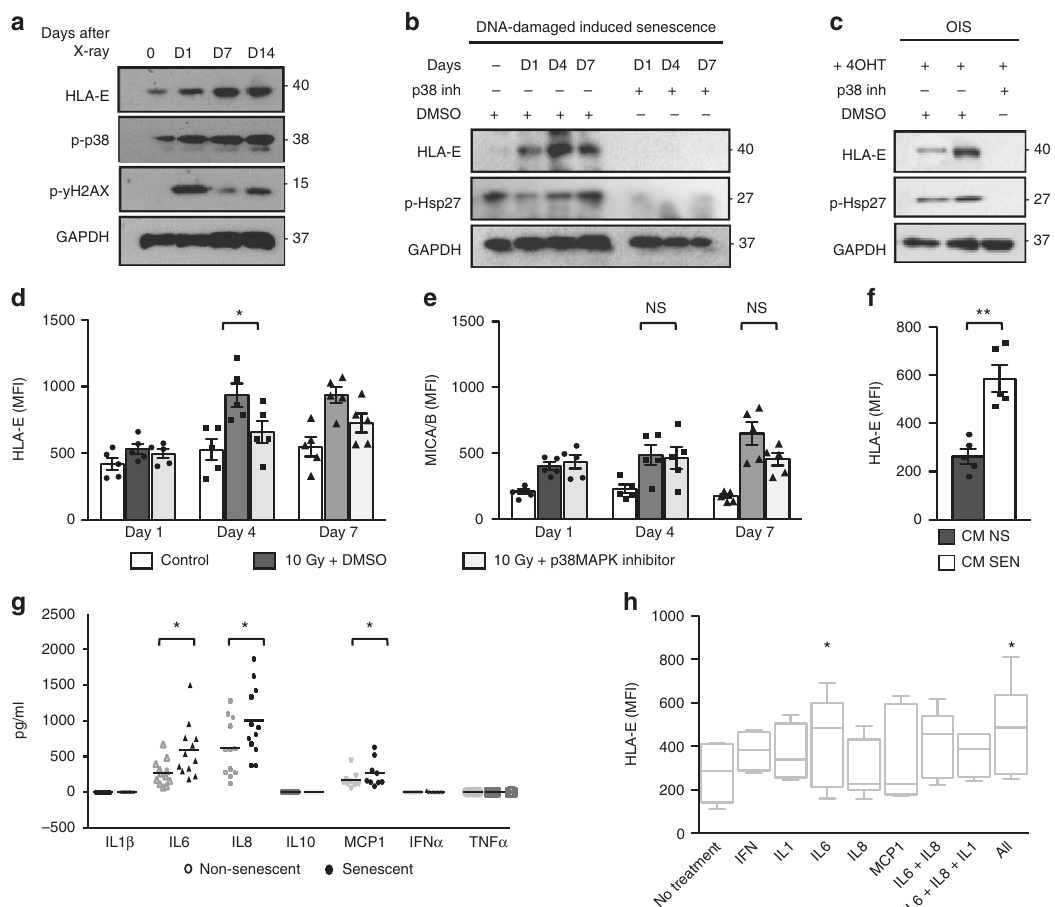
Fig. 2 HLA-E expression on senescent cells is regulated by p38 and induced by IL-6. a Representative immunoblot of human fi broblasts at the indicated intervals after IR showing the kinetics of HLA-E, p38 (Thr180/Tyr182) and γ H2AX (Ser139) phosphorylation. b Human fi broblasts were treated with p38 inhibitor BIRB796 (0.5 μ M) or DMSO 12 h before, and for 7 days after IR. Immunoblot of HLA-E expression at the indicated intervals after IR compared with DMSO-treated controls. Undetectable levels of phospho-Hsp27 (p-Hsp27) con fi rm effective inhibition of p38. c IMR-90 ER:STOP/ER:RAS cells treated with 4-OHT to induce senescence (as demonstrated in Supplementary Fig. 2A – C) and treated with BIRB796 (0.5 μ M) or DMSO over 7 days, followed by protein extraction and immunoblot analysis of HLA-E and p-Hsp27. GAPDH served as a loading control in a – c . Uncropped immunoblots are provided in the Source Data fi le. d The summary data of HLA-E and ( e ) MICA/B expression analysed by fl ow cytometry on irradiated fi broblasts treated with SB203580 (10 μ M), compared with DMSO-treated and non-irradiated controls ( n = 5). f Flow-cytometry analysis of HLA-E expression on fi broblasts exposed to the conditioned medium (CM) from senescent (SEN) or non-senescent (NS) cells for 48 h ( n = 5). g Supernatant from irradiated senescent or early-passage fi broblasts analysed by cytokine-bead arrays to measure secreted cytokines (in pg/mL) ( n = 12). h Fibroblasts were exposed to